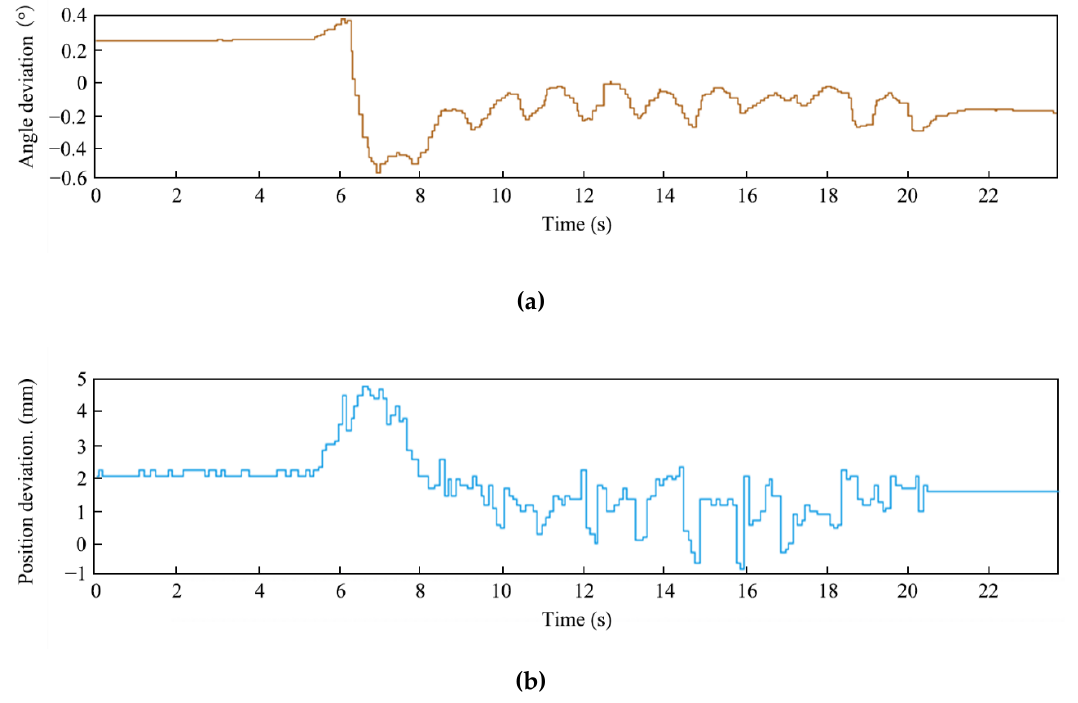
Figure 16. AGV trajectory deviation: ( a ) Angle deviation; ( b ) Position deviation.